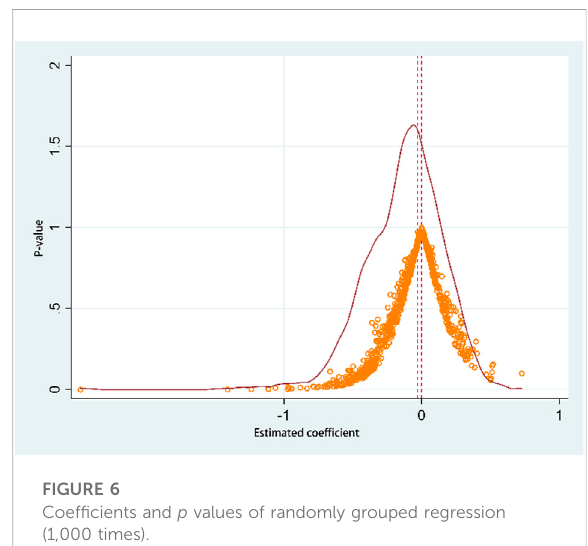
FIGURE 6 Coef fi cients and p values of randomly grouped regression (1,000